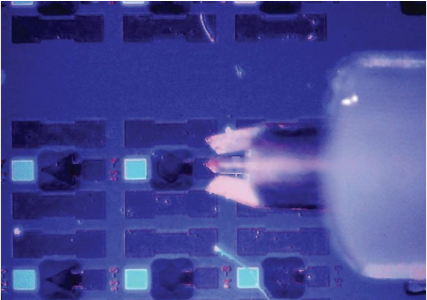
Figure 1: Te FBAR array surface views under the microprobe of the probe station when the FBAR sensor was fxed on the probe station platform before experiment.